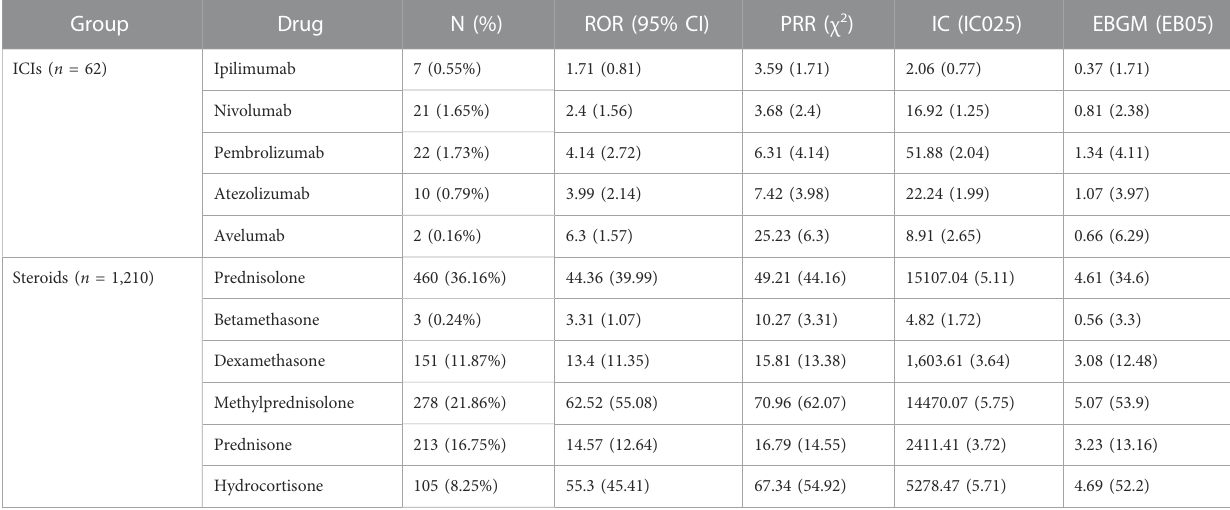
TABLE 3 Case numbers and detected signals of ICIs-related or steroids-related pneumatosis intestinalis.